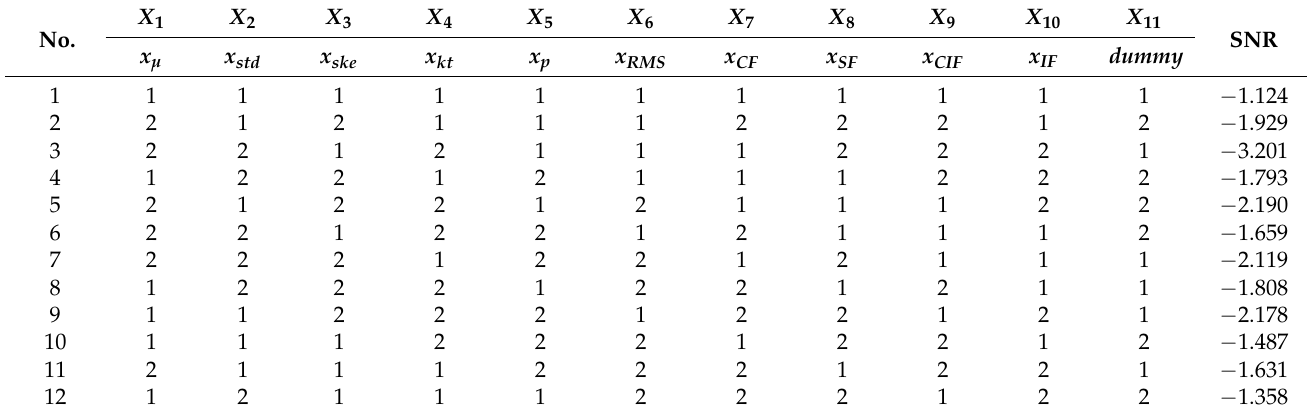
Table 7. SN ratios with L 12